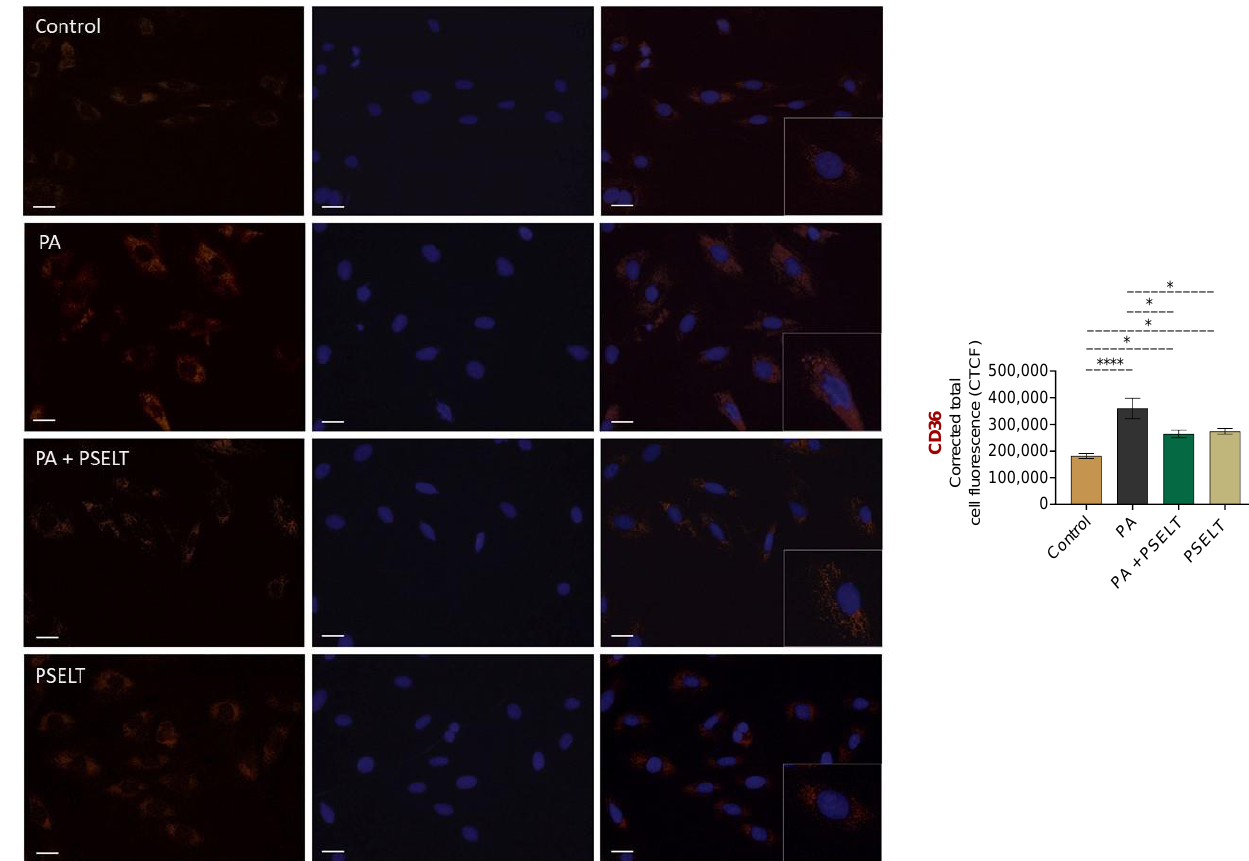
Figure 4. Effects of PSELT on CD36 expression in PA-treated H9c2 cardiomyocytes. Representative images of cardiomyocytes treated with vehicle or PA (100 µmol/L) and PSELT (5 nmol/L) alone or in co-treatment for 24 h. CD36 expression was assessed by using an anti-CD36 primary antibody (Thermo Fisher scientific) and a donkey anti-rabbit secondary antibody—Alexa Fluor™ 555 (red) (Invitrogen). Nuclei were counterstained with DAPI (blue). Scale bars: 25 µm. Data are expressed as the mean ± SEM ( n = 3 different experiments). Significant differences in CTCF were detected by one-way ANOVA and Newman-Keuls multiple comparison test, p < 0.05 (*) and p < 0.0001 (****). 3.5. PSELT Mitigates the Detrimental Effects of PA on Mitochondrial Function, Biogenesis, and Dynamics To evaluate the effects of PSELT on mitochondrial function during PA treatment, we performed metabolic flux analysis using the Seahorse XFe96. In H9c2 cardiomyocytes, a dramatic reduction in the oxygen consumption rate (OCR) was observed after treatment with PA, whereas PSELT mitigated this effect (Figure 5A and Supplementary Figure S2). We next investigated whether the protective action of PSELT could also be linked to mitochondrial biogenesis and dynamics; to this aim, we carried out Western blot analyses aimed at assessing specific markers involved in these molecular processes. Figure 5B shows that PA significantly reduced the levels of PGC1-α, a master regulator of mitochon- drial biogenesis, compared to control cells. However, PSELT treatment significantly in- creased these levels in the presence of PA compared to cells exposed only to PA (Figure 5B). Moreover, we assessed whether PSELT could influence the expression levels of DRP- 1, a key regulator of mitochondrial fission, and OPA-1, a gatekeeper of stress-sensitive mitochondrial fusion. Our results indicate that PA triggered a significant increase in both DRP-1 and OPA-1 expression compared to the control group, which was significantly re- versed in the presence of PSELT (Figure 5C,D).